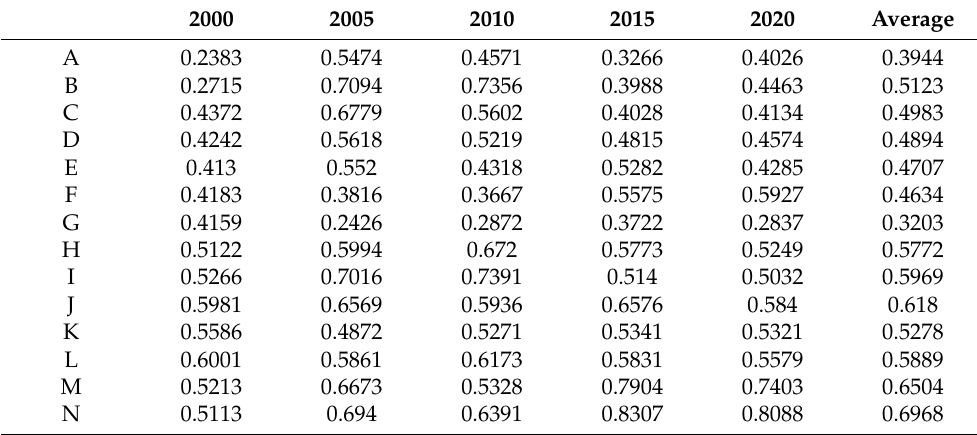
Figure 6. The WIRSEI of the whole, land, and water areas of Wuhan from 2000 to 2020. Table 4. Water RSEI of major lakes and rivers.